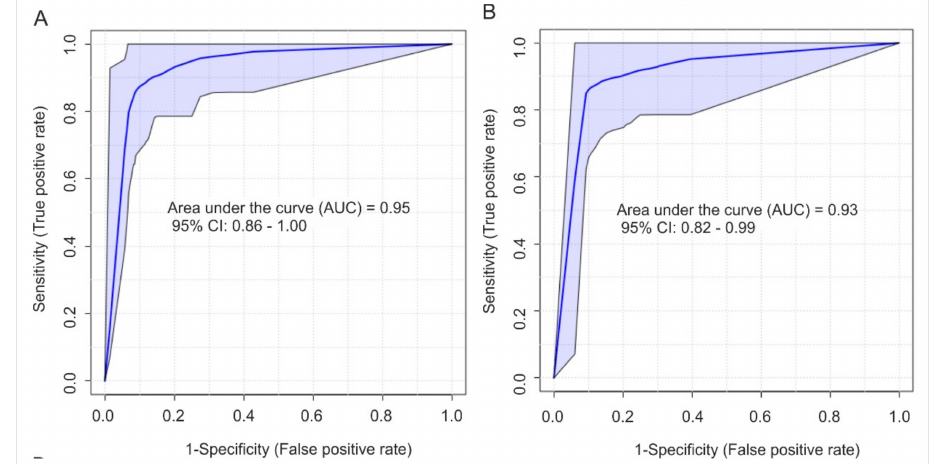
Figure 3. ROC curve for the diagnostic accuracy of selected metabolites from NMR spectroscopy for the diagnosis of KDIGO AKI obtained from a linear regression analysis using ( A ) four selected features (citrate (2.69 ppm), leucine (0.96 ppm), valine (1.00 ppm), and bile acid (0.69–0.81 ppm)) and ( B ) six selected features (citrate (2.69 ppm), leucine (0.96 ppm), valine (1.00 ppm), bile acid (0.69–0.81 ppm), unk_al1 (3.16 ppm), and unk_al28 (2.12–2.17 ppm)). AKI, acute kidney injury; KDIGO, Kidney